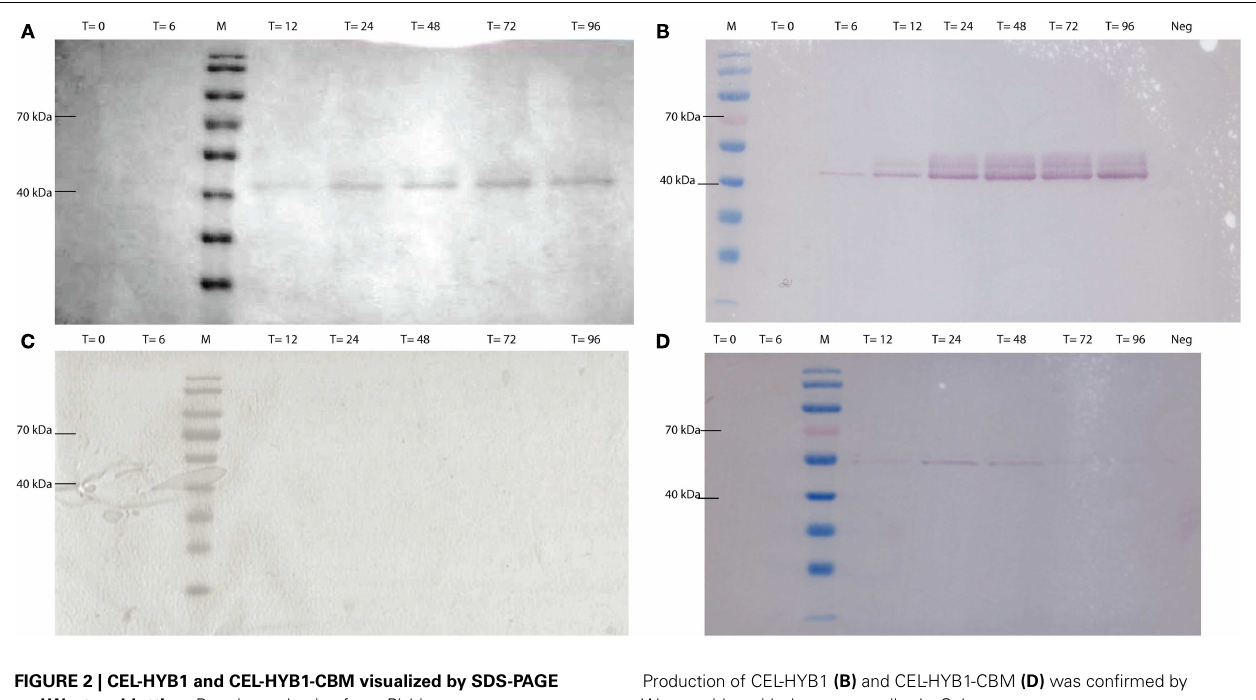
FIGURE 2 | CEL-HYB1 and CEL-HYB1-CBM visualized by SDS-PAGE andWestern blotting. Protein production from Pichia pastoris _CEL-HYB1 (A) and P. pastoris _CEL-HYB-CBM (C) induced with 0.5% methanol; heterologous protein excreted in the supernatant was visualized using SDS-PAGE and Coomassie Brilliant Blue staining.